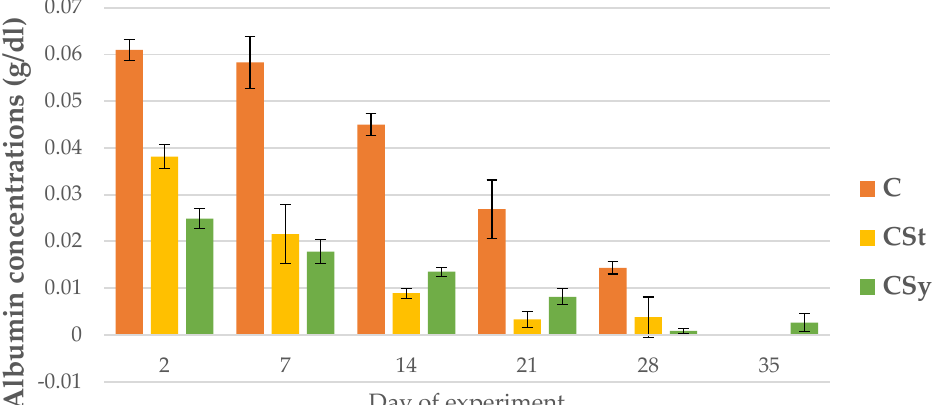
Figure 16. Albumin concentration in the 2, 7, 14, 21, 28, 35-day-old workers’ hemolymph after two methods of supplementation with hemp extract: C-control (pure sugar syrup), CSy-hemp extract in syrup, CSt-hemp extract on strips. Two-Way ANOVA: supplementation method: F (2, 156) = 69.318, p = 0.0000, se ± 0.002002 – 0.011302; days of supplementation: F (4, 143) = 561.33, p = 0.0000, se 0.000596 – 0.001033; supplementation method × days of supplementation F (8, 143) = 47.417, p = 0.0000, se 0.001033 – 0.001089.